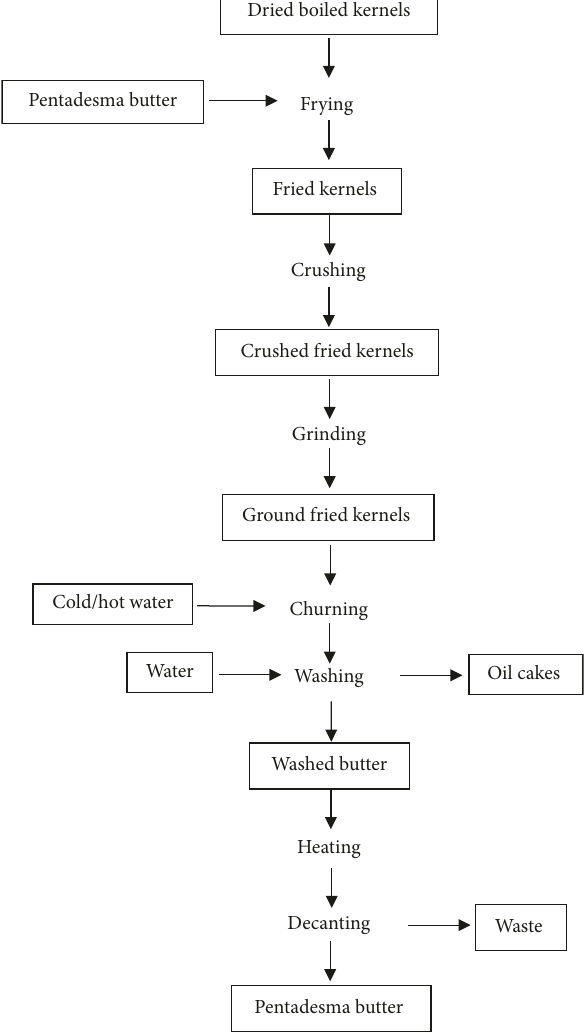
Figure 1: Traditional method 1 for extracting butter from P. butyracea